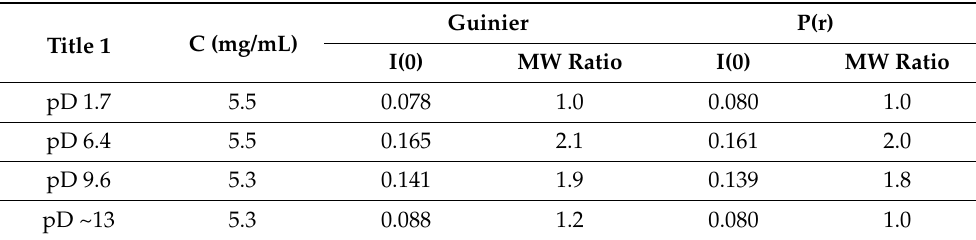
Figure 5. The ab initio bead models generated by the program DENFERT [27,28], and fitting of the crystal structure into each volumetric map (bottom panel) at pD 6.4 ( A ), 9.6 ( B ), and ~13 ( C ). The four B helices were docked in the volumetric map for ( C ) using the program Situs [51]. All models are drawn with the same scaling factor. Table 3. Concentration (C) of Cyt c ’, I(0) and estimated molecular weight ratio from experimental SANS curves at each pD condition.